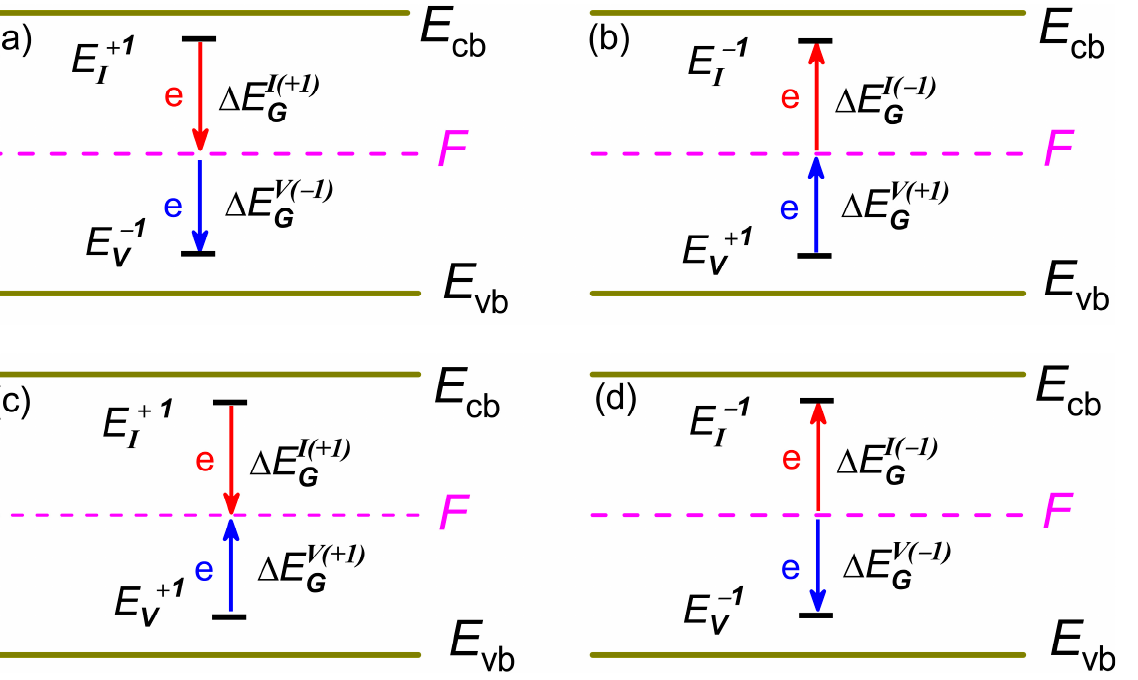
Figure A1. Schematic energy diagram for the Frenkel pair containing ( a ) the once negatively charged vacancy and the once positively charged interstitial atom, ( b ) the once positively charged vacancy and the once negatively charged interstitial atom, ( c ) the once positively charged vacancy and the interstitial atom, and ( d ) the once negatively charged vacancy and the interstitial atom. The arrows show the change (up = increase and down = decrease) in the electronic system energy released at the charged defect formation.